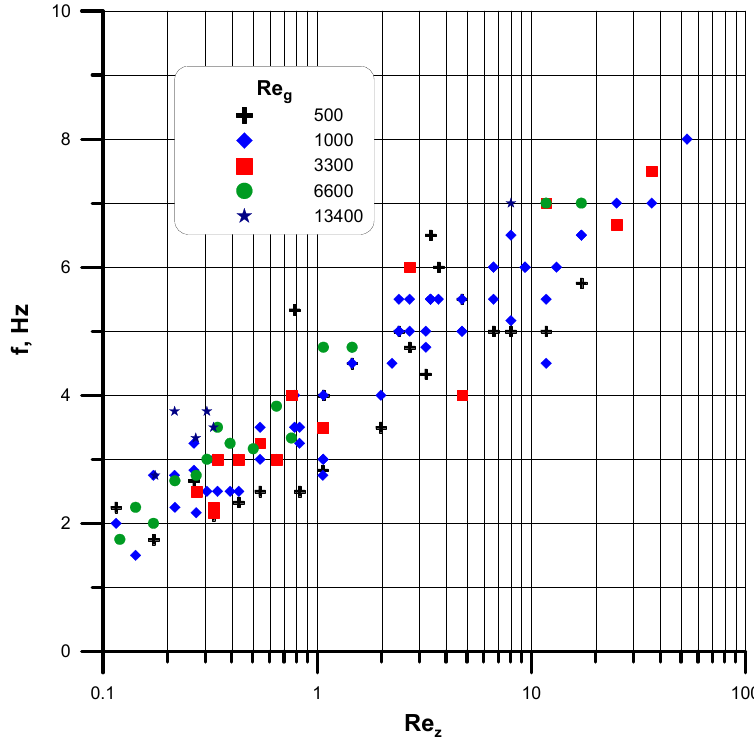
Figure 6. Results of experiments and calculations of wave frequency f = f(Re z , Re g ) accompanying annular gas–very viscous liquid flow. Energies 2020 , 13 , x FOR PEER REVIEW